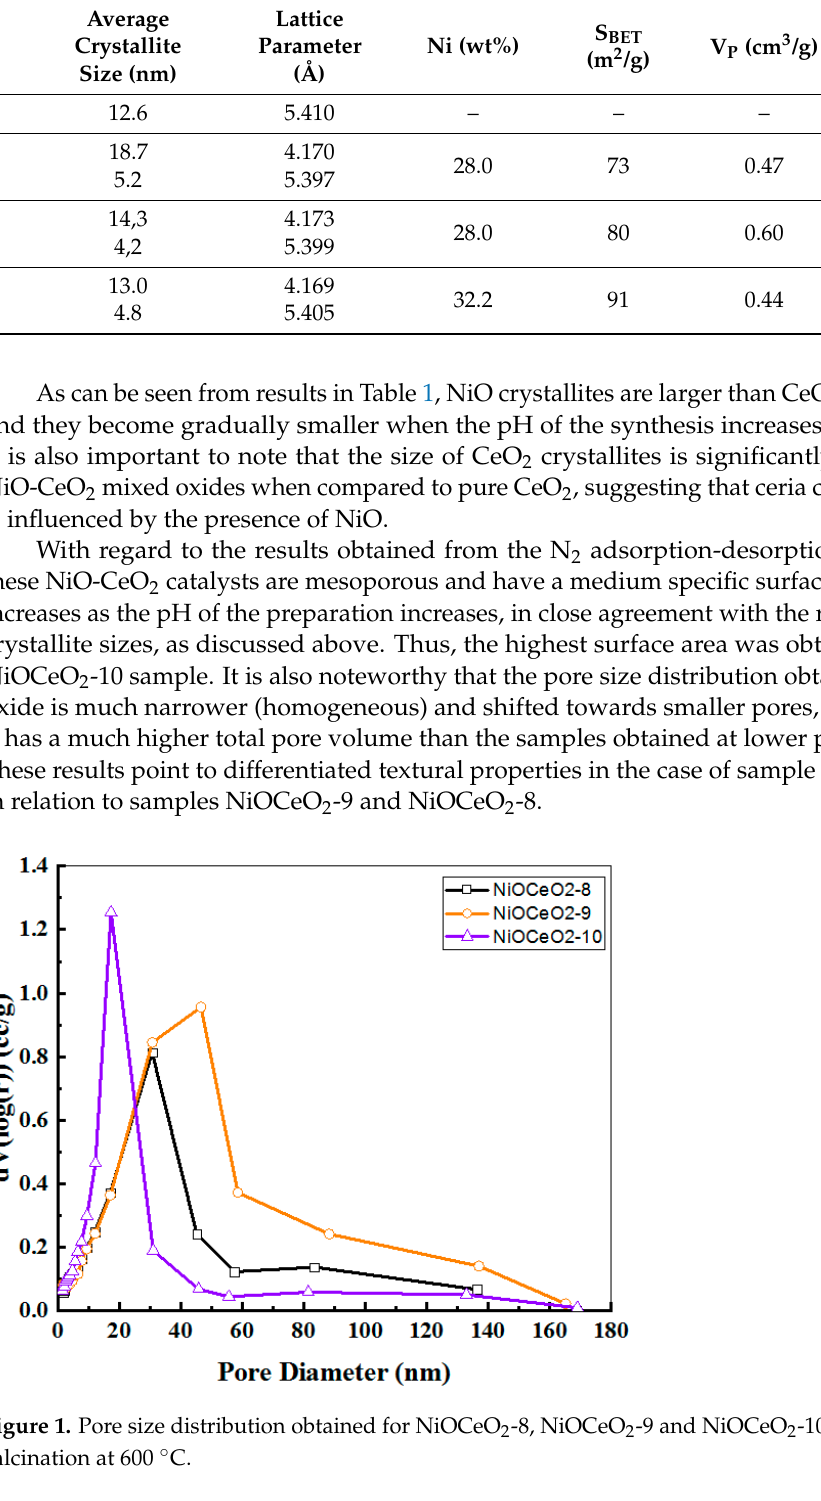
Table 1. Structural and textural properties (XDR data, Ni content (ICP), BET surface area, pore volume, pore diameter) of NiOCeO 2 catalysts after calcination at 600 ◦ C.